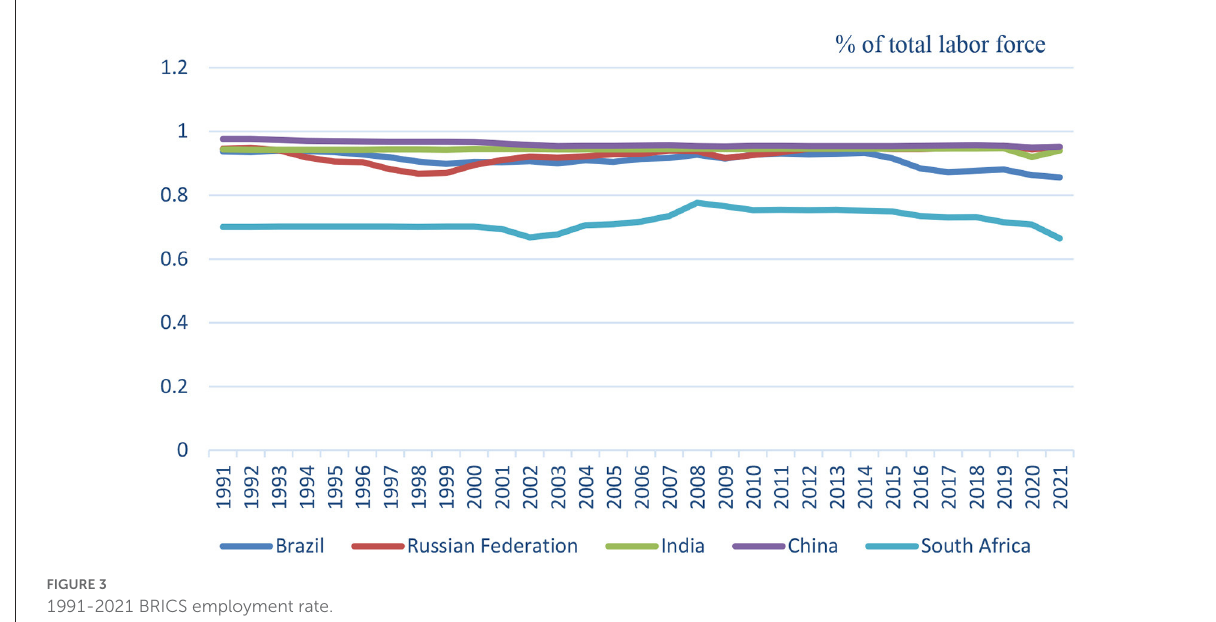
FIGURE3 1991-2021 BRICS employment